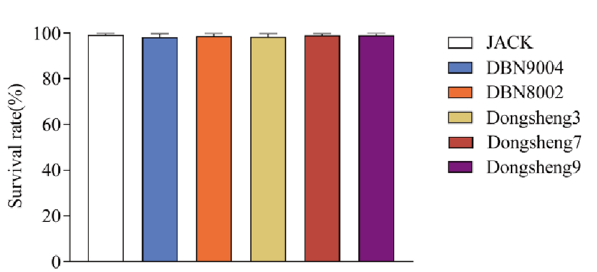
Figure 1. The survival rate of juvenile channel catfish fed different types of soybean diets. The total 30 aquarium tanks were randomly arranged to six treatment groups (JACK (served as a control), DBN9004, DBN8002, Dongsheng3, Dongsheng7, and Dongsheng9), with five aquarium tanks in each group. The survival rate of fish in each aquarium was recorded. Data are presented as mean ± SE (n = 5). * p < 0.05 versus JACK ( t -test).